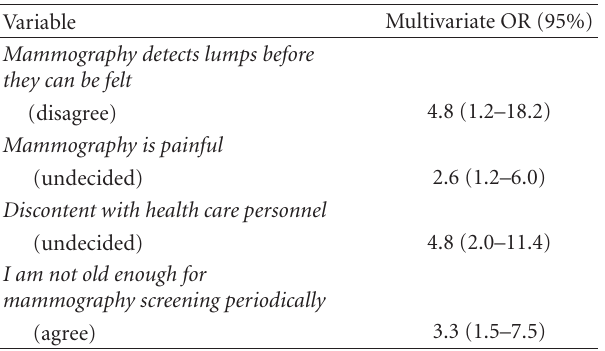
Table 5: Multivariate OR’s of nonattendance at mammography screening.